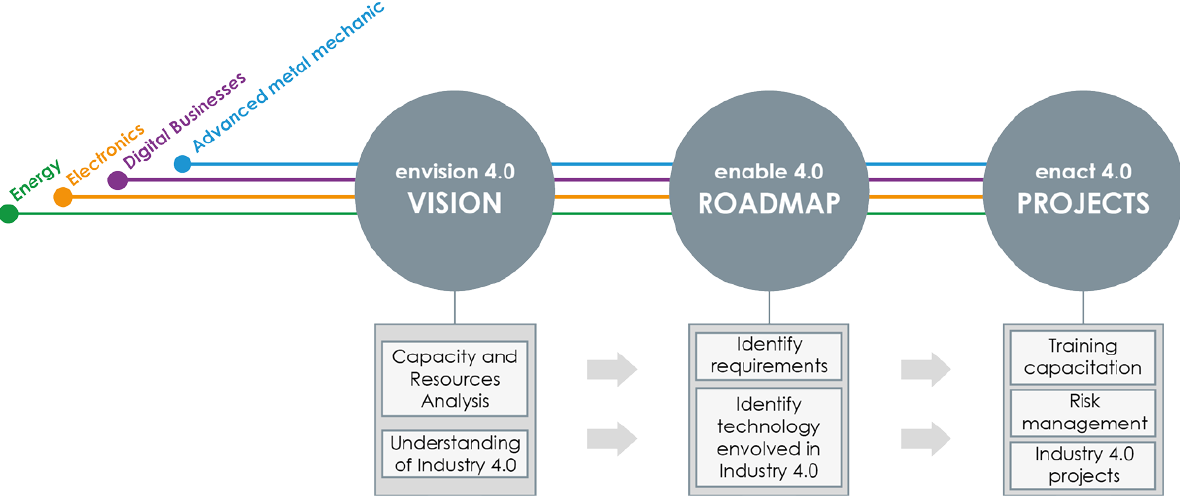
Figure 1. Description of the Methodology for Industry 4.0 Collaborative